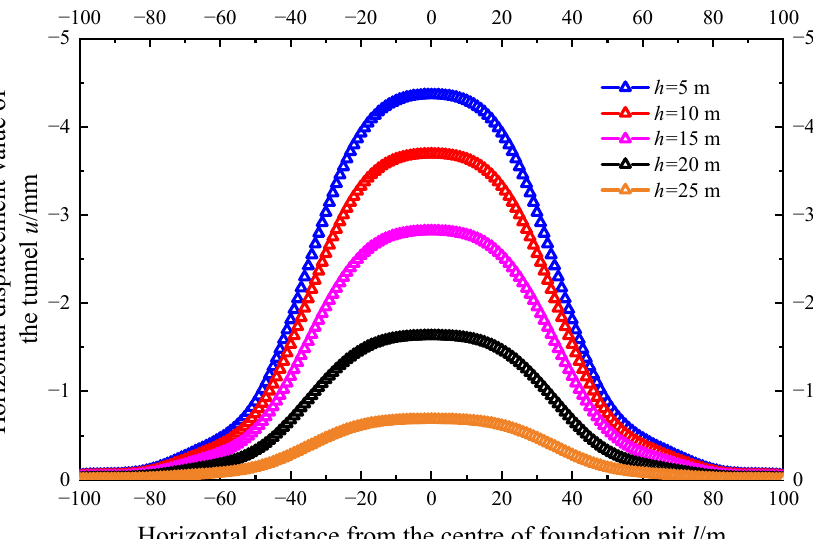
Figure 19. The longitudinal distribution curve of the horizontal displacement of the shield tunnel by the side of the foundation pit under different h conditions.